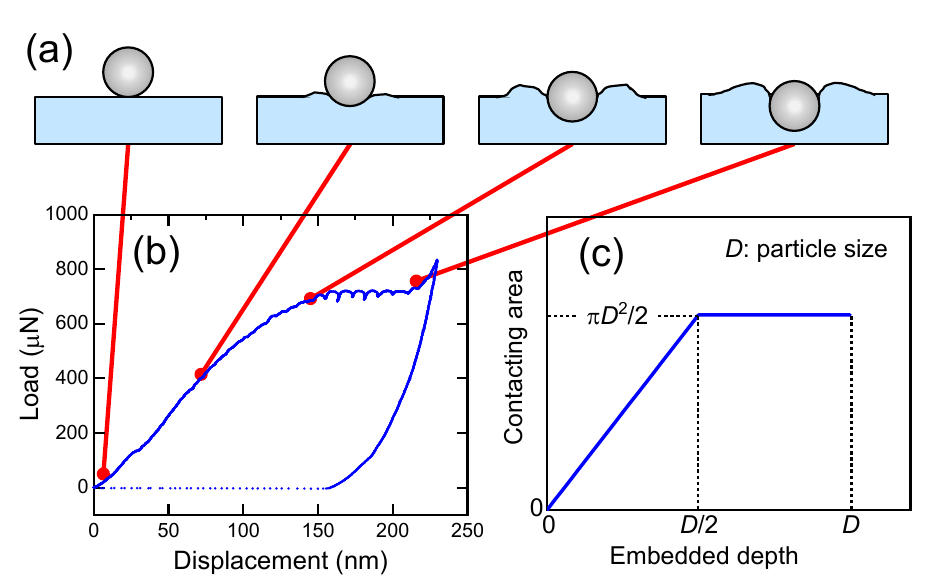
Figure 9. Embedding process of TiC SMPs on an Al substrate. ( a ) Schematic illustration of the particle embedment process. ( b ) Typical load–displacement curve of TiC SMPs on Al substrate. ( c ) Calculated relationship between the particle-surface contact area and embedded depth.